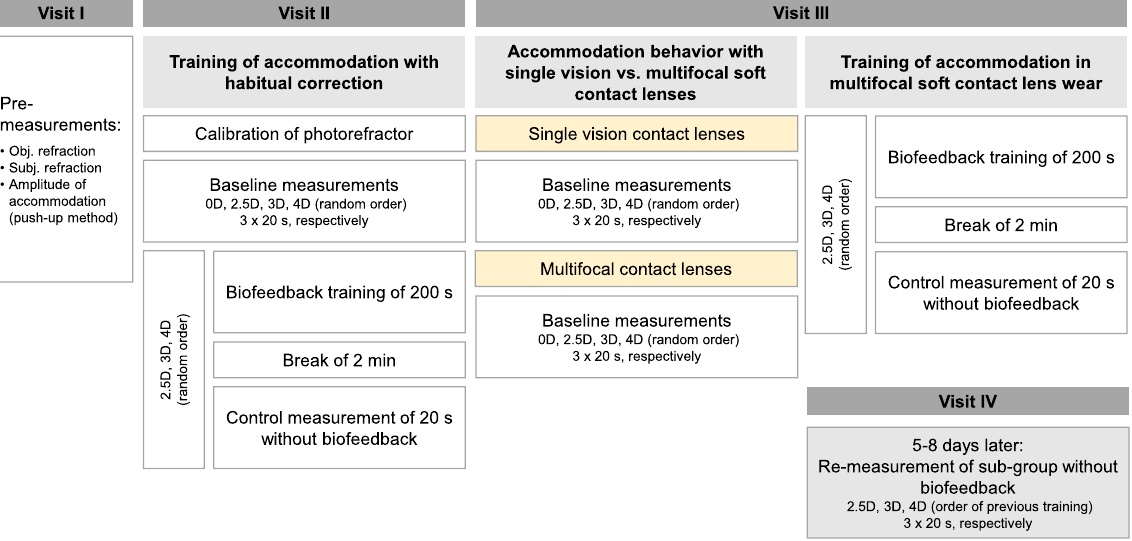
Figure 5. Description of trial procedure. Overview of first, second, third, and forth visit with description of respective measurement